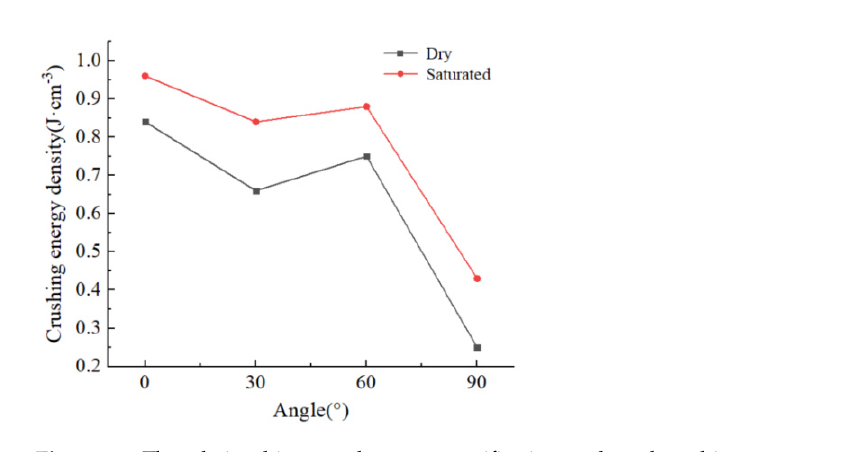
Figure 11. The relationship curve between stratification angle and crushing energy consumption density.